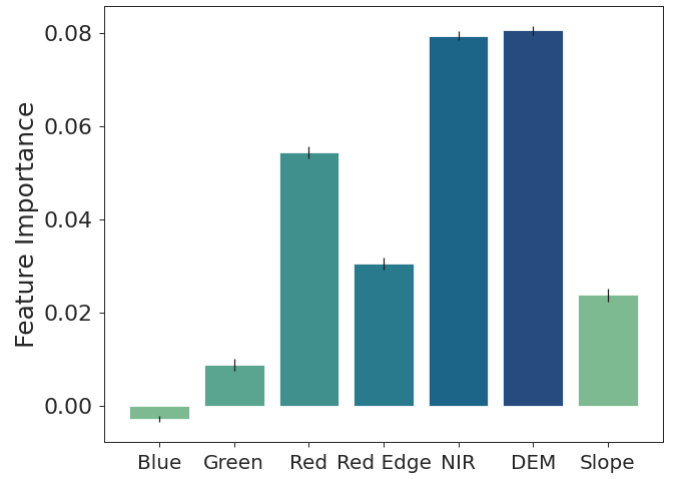
Figure 13. The importance score of model inputs in pixel-based